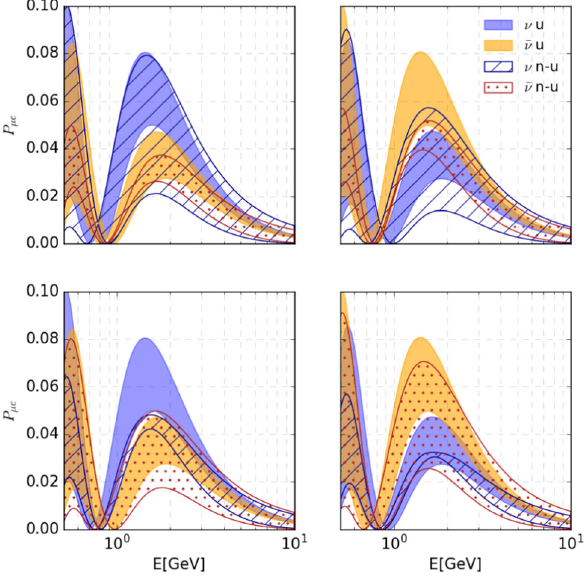
Fig. 5 Ratio of the non-unitary to unitary oscillation probabilities as a function of L / E and δ CP . The reference energy E = 0 . 7 GeV has been fixed to the T2K flux peak energy. For this peak energy and T2K baseline, L / E = 421. The upper (lower) panel shows the ratio for NH (IH), the left (right) panel shows it for neutrino (anti-neutrino). The non-unitary parameters are fixed to their boundary values in Eq. (18) taken from Ref. [46] and we have set φ 10 =